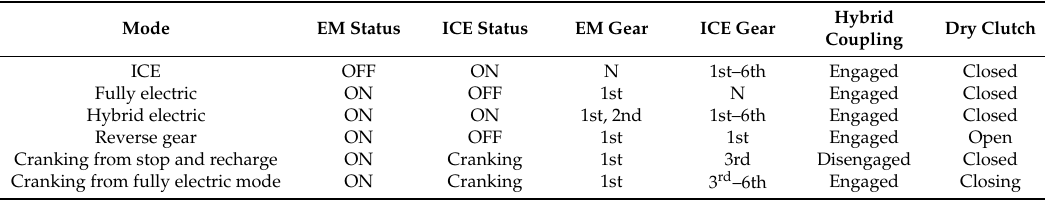
Table 2. Operating modes of the HAMT and the corresponding status of each actuator (the status of the actuators during gear shifts is not